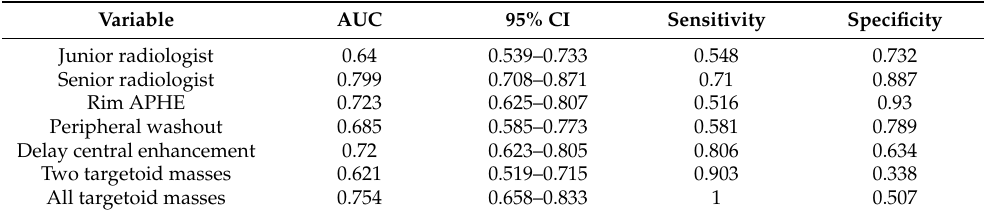
Table 4. Discrimination Performance of the Radiologists and Targetoid Masses for HCC and non-HCC in LR-M